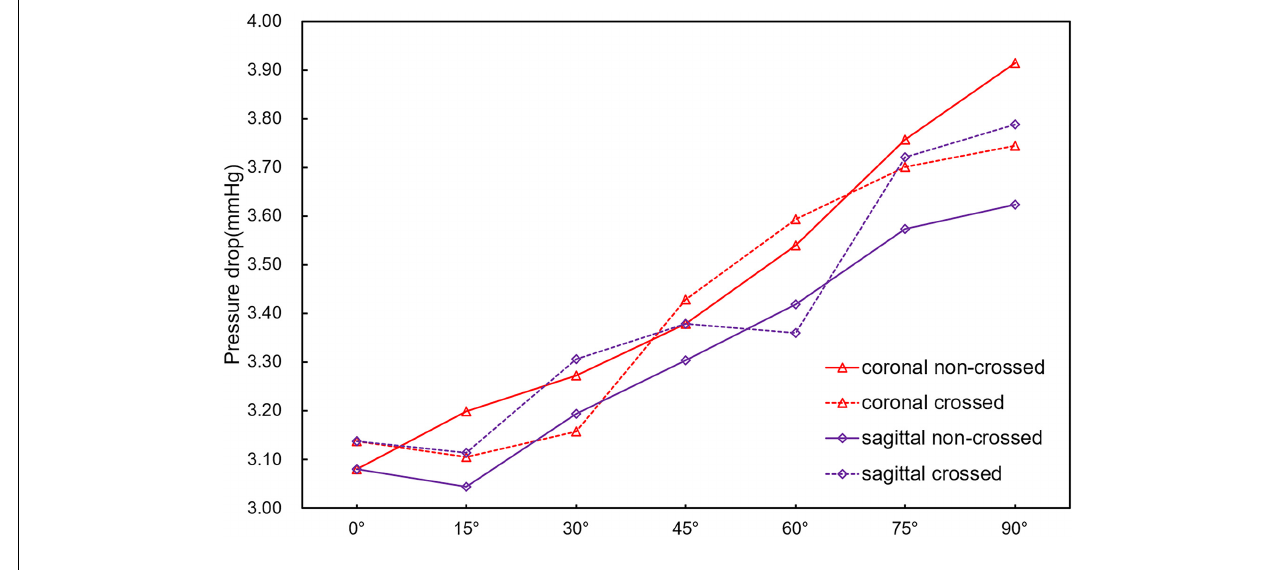
FIGURE 5 | Broken line chart of inlet and outlet pressure drop at peak systolic time.